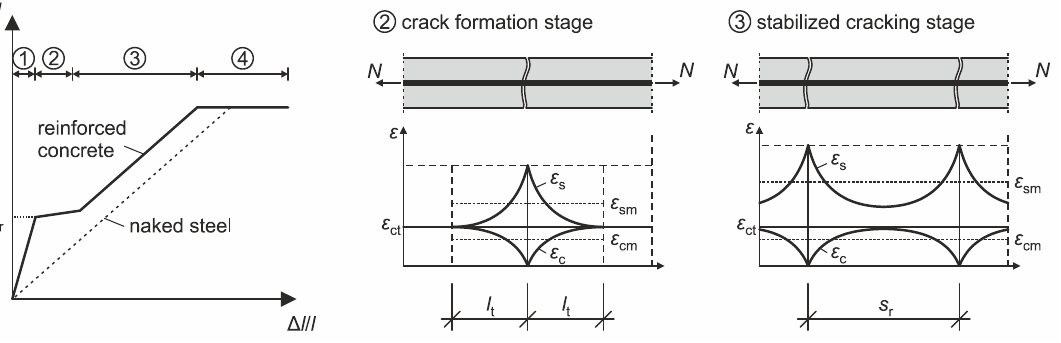
Figure 1. Stages of crack propagation in reinforced concrete specimens in uniaxial tensile tests. The crack width in the crack formation stage results from the integration of the strain differences between the reinforcement and surrounding concrete over the transmission length on both sides of the observed crack. In the stabilized cracking stage, the crack width is determined by integrating the strain difference over half of the crack spacing on both sides of the considered